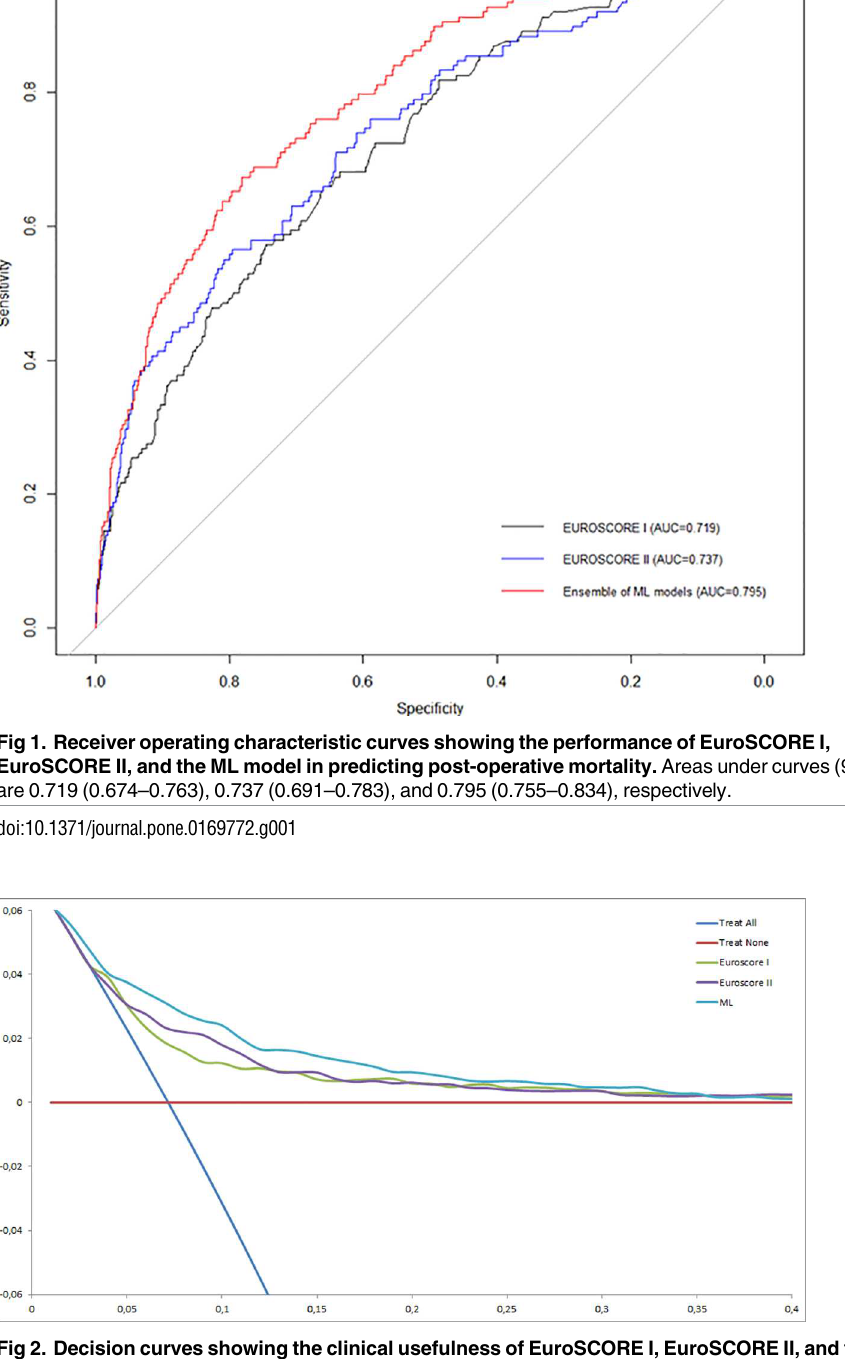
Fig 2. Decision curves showing the clinical usefulness of EuroSCORE I, EuroSCORE II, and the ML model in predicting post-operative mortality. The blue line represents the net benefit of providingsurgery for all patients, assumingthat all patients wouldsurvive. The red line representsthe net benefit of surgery to none patients, assuming that all would die after surgery. The green, purple and turquoiselines representthe net benefit of applyingsurgery to patients accordingto EuroSCORE I, EuroSCORE II, and ML model, respectively. The selectedprobabilitythreshold ( i . e ., the degreeof certitude of postoperative mortality over which the patient’s decisionis not to operate) is plotted on the